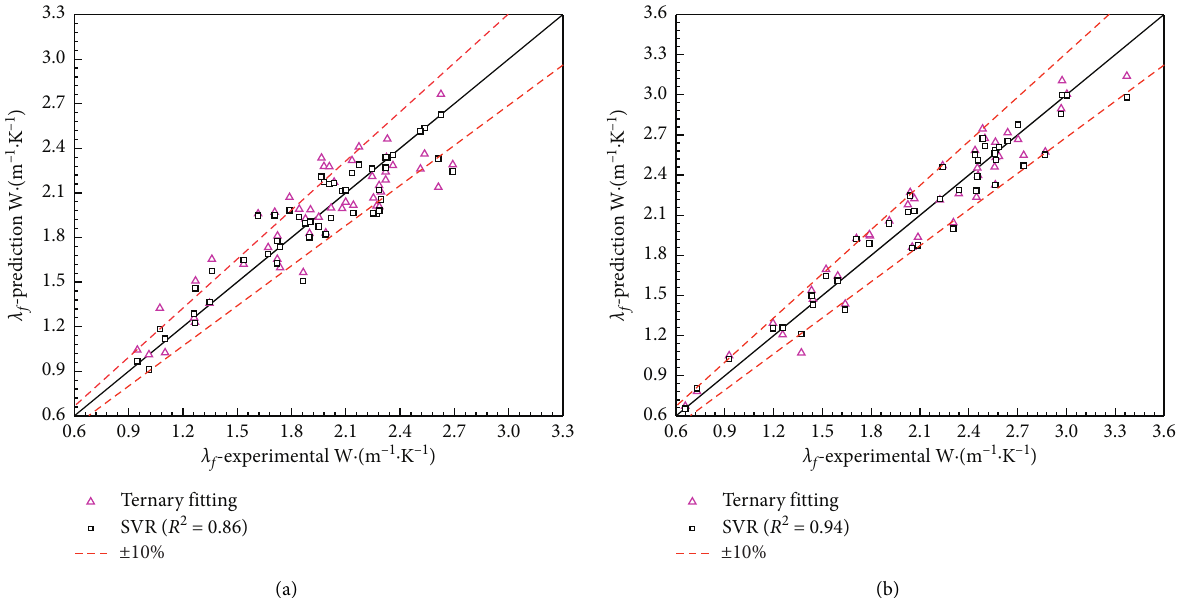
Figure 7: Predictive results of SVR models for (a) slit and (b) gravel